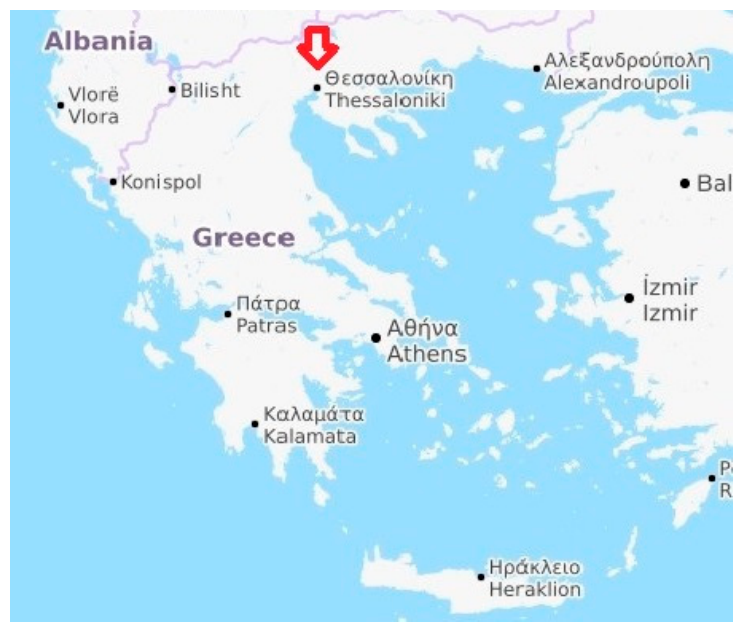
Figure 1. Thessaloniki, Greece. Source. [©OpenStreetMap and Contributors].